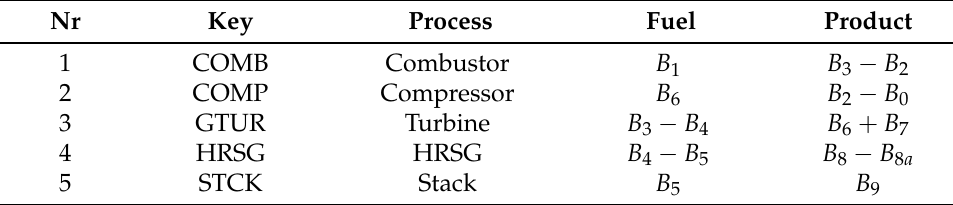
Table 2. Processes description and efficiency definition of TGAS